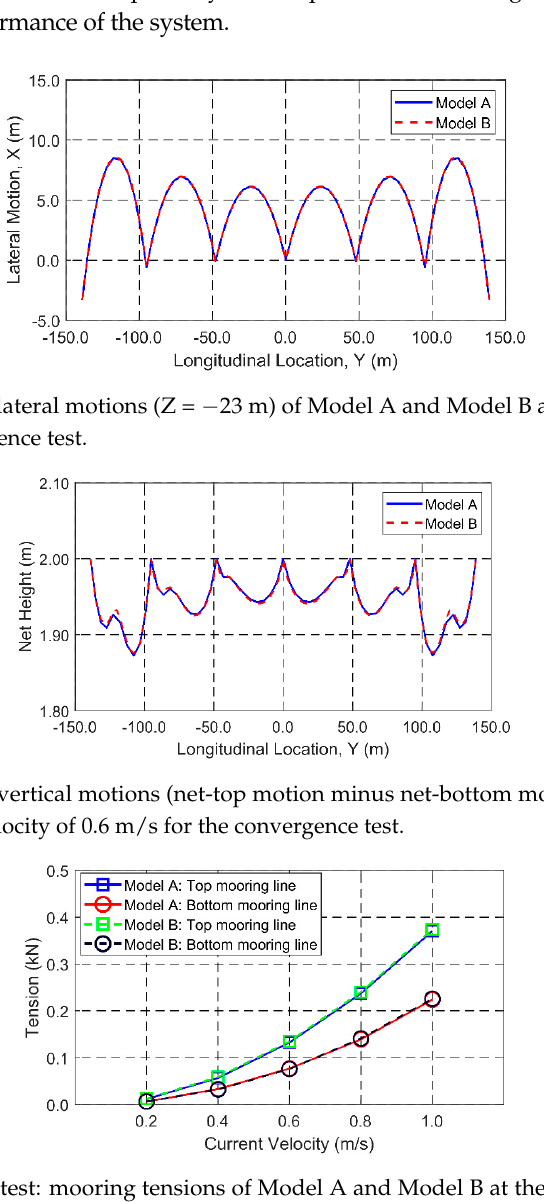
Figure 5. Convergence test: mooring tensions of Model A and Model B at the middle location with different current velocities.